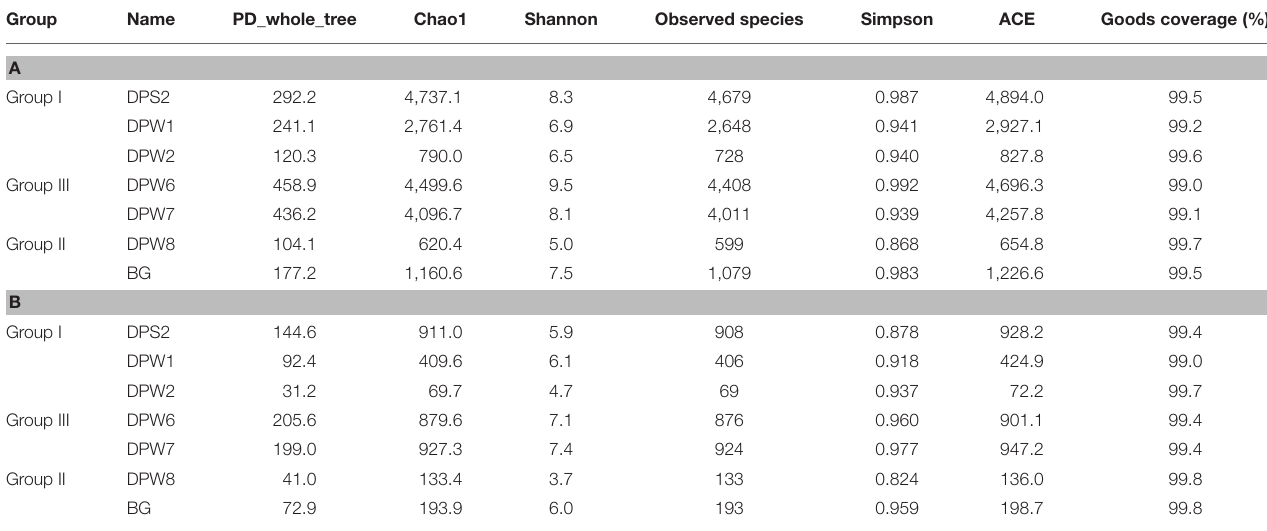
TABLE 2 | Comparison of bacterial (A) and archaeal (B) diversity richness and evenness in MiSeq sequencing with 341F-805R. Group Name PD_whole_tree Chao1 Shannon Observed species Simpson ACE Goods coverage